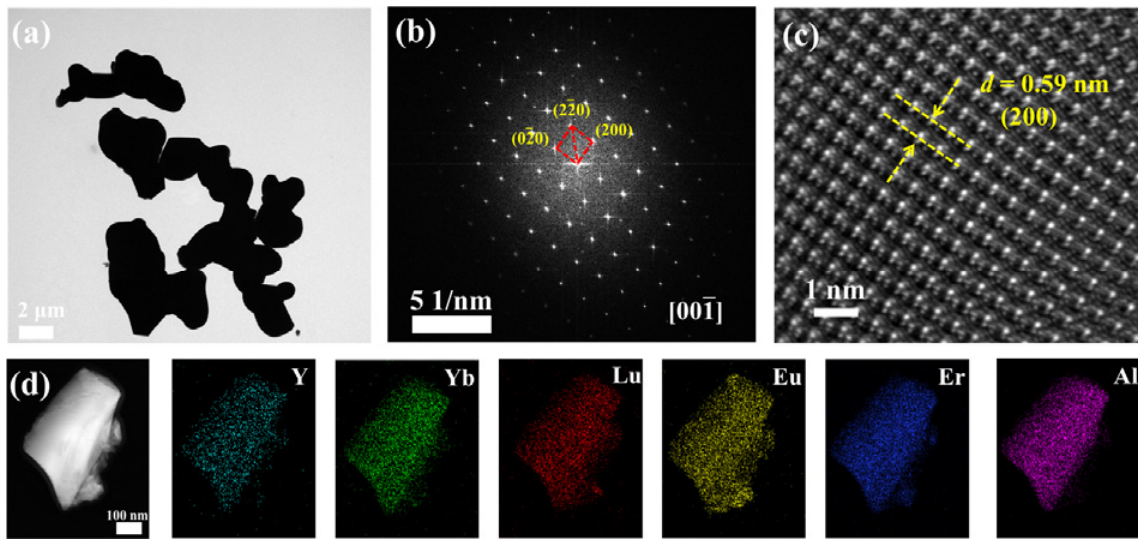
Fig. 3 (a) TEM image of the as-synthesized HE-RE 3 Al 5 O 12 ceramic powders. (b) SAED and (c) HRTEM patterns of a single HE-RE 3 Al 5 O 12 ceramic microparticle. (d) EDS elemental mappings on the microparticle. 0.59 nm), the calculated lattice parameter is a = 11.8